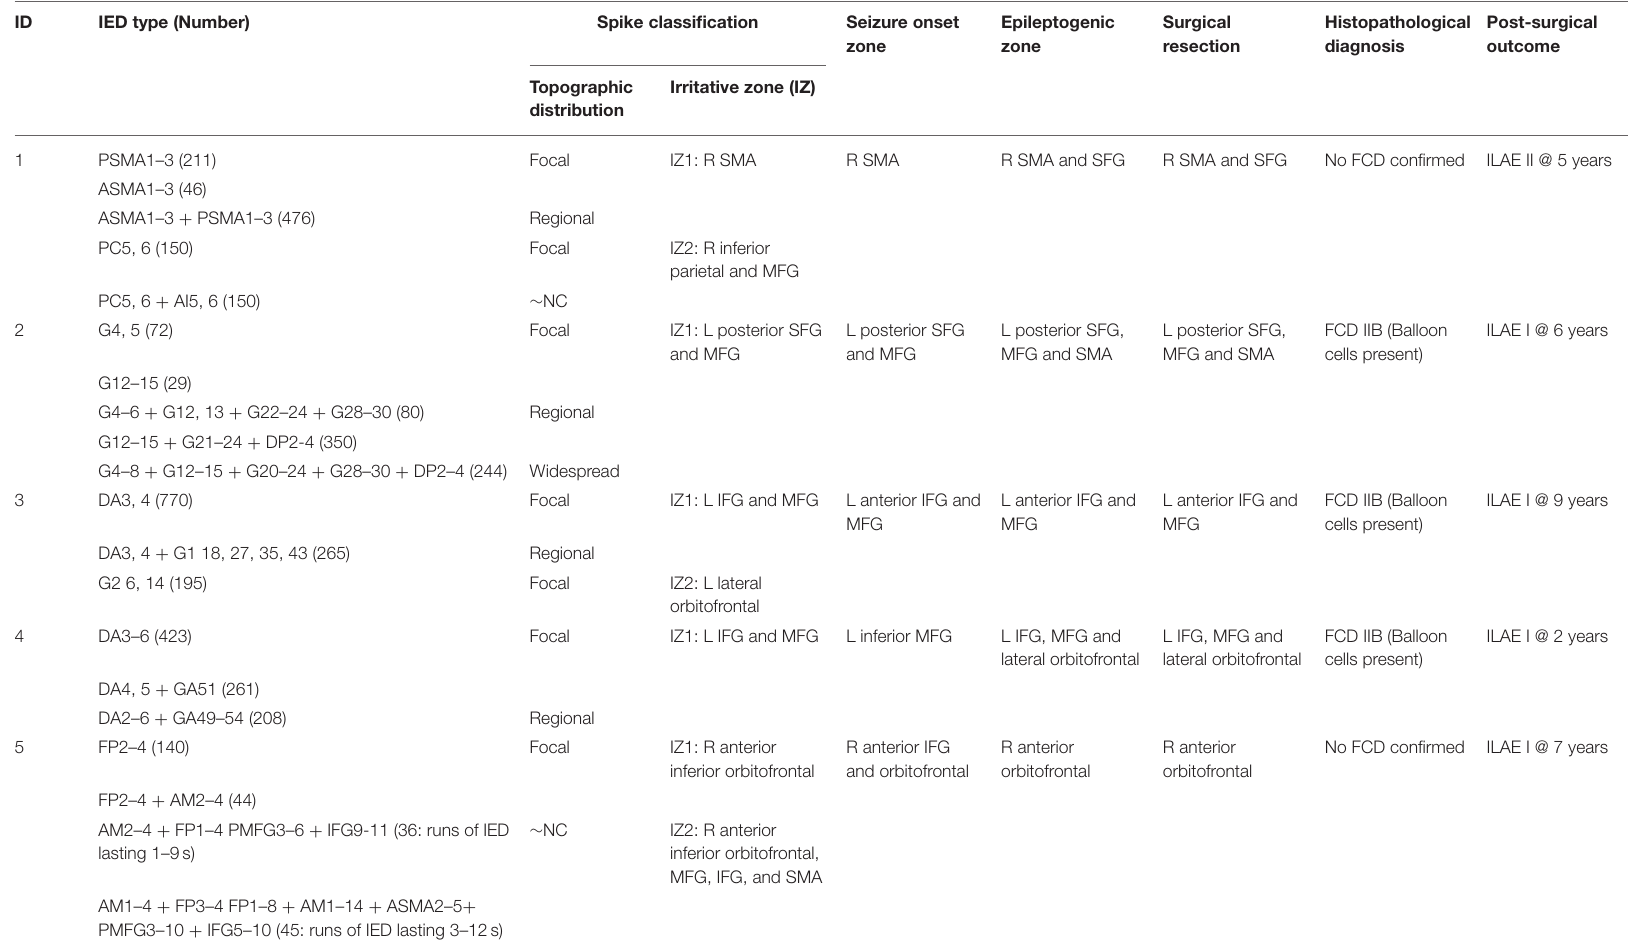
TABLE 2 | Invasive localization and post-surgical